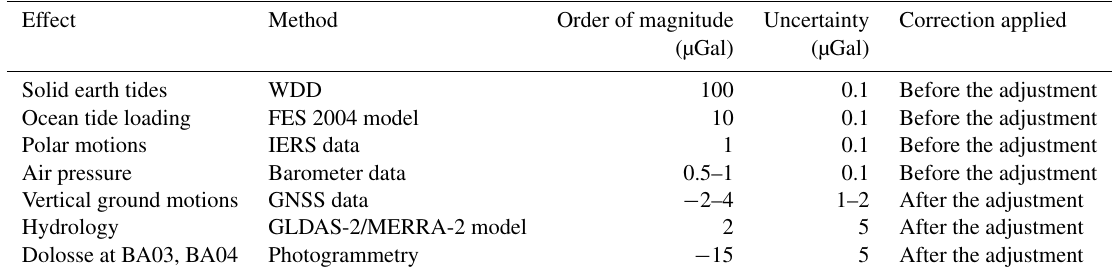
Table 1. Summary of the corrections applied to our gravity measurements with their order of magnitude and a statement on whether they are applied before or after the drift adjustment. The uncertainties of the first four corrections are those proposed by Van Camp et al. (2005). See text for the methods’ references.